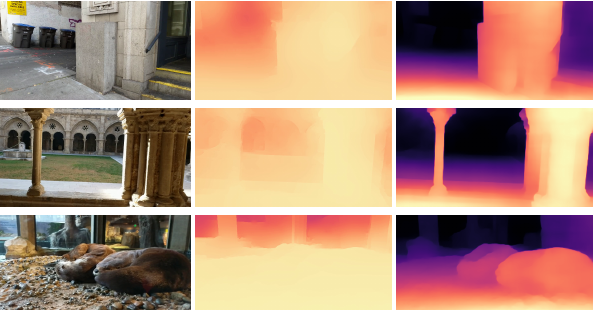
Figure 8. Qualitative comparison with other occlusion-aware AR methods. From left to right, the input image; the depths from [55] and PyDNet predictions.